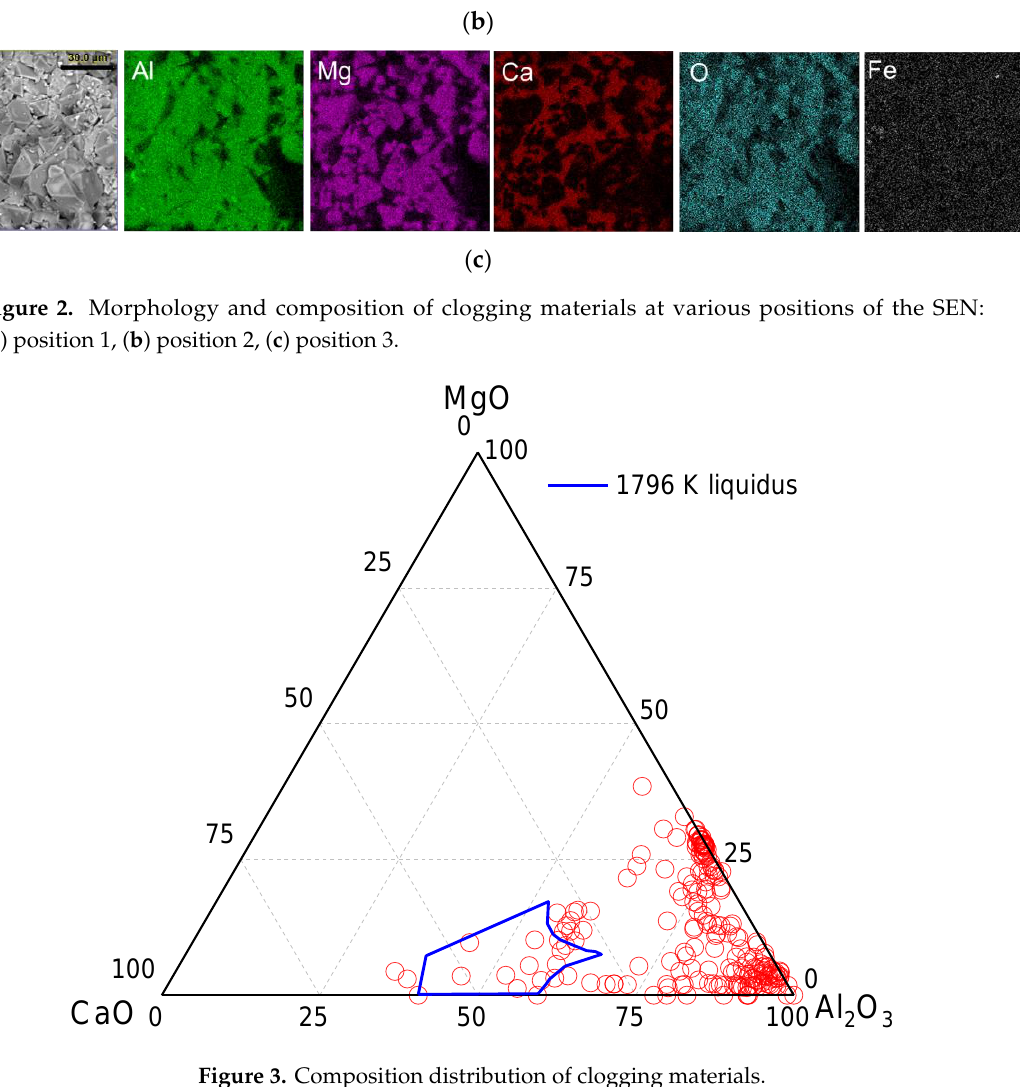
Figure 3. Composition distribution of clogging materials.